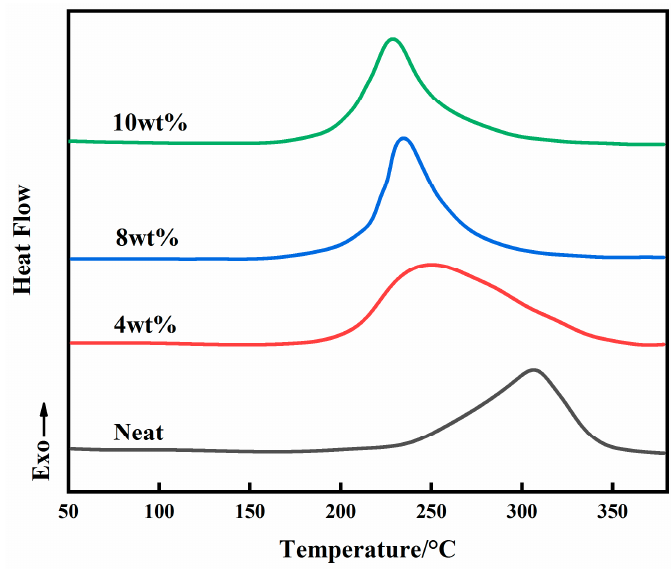
Figure 6. DSC curves of the BADCy matrix with different BADCy resin nanoparticles contents. Table 1. Thermal characteristics of samples. BADCy: Bisphenol A dicyanate.